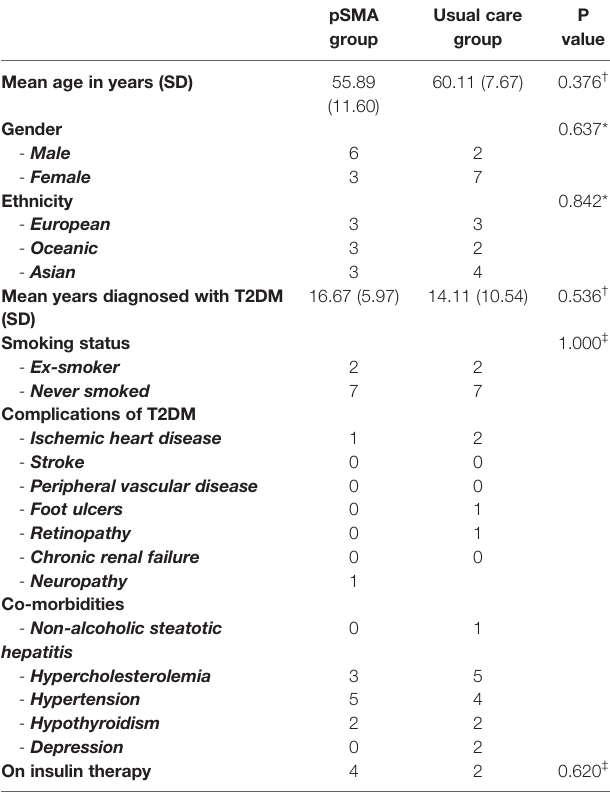
TABLE 2 | Between-group comparison of measures at baseline.